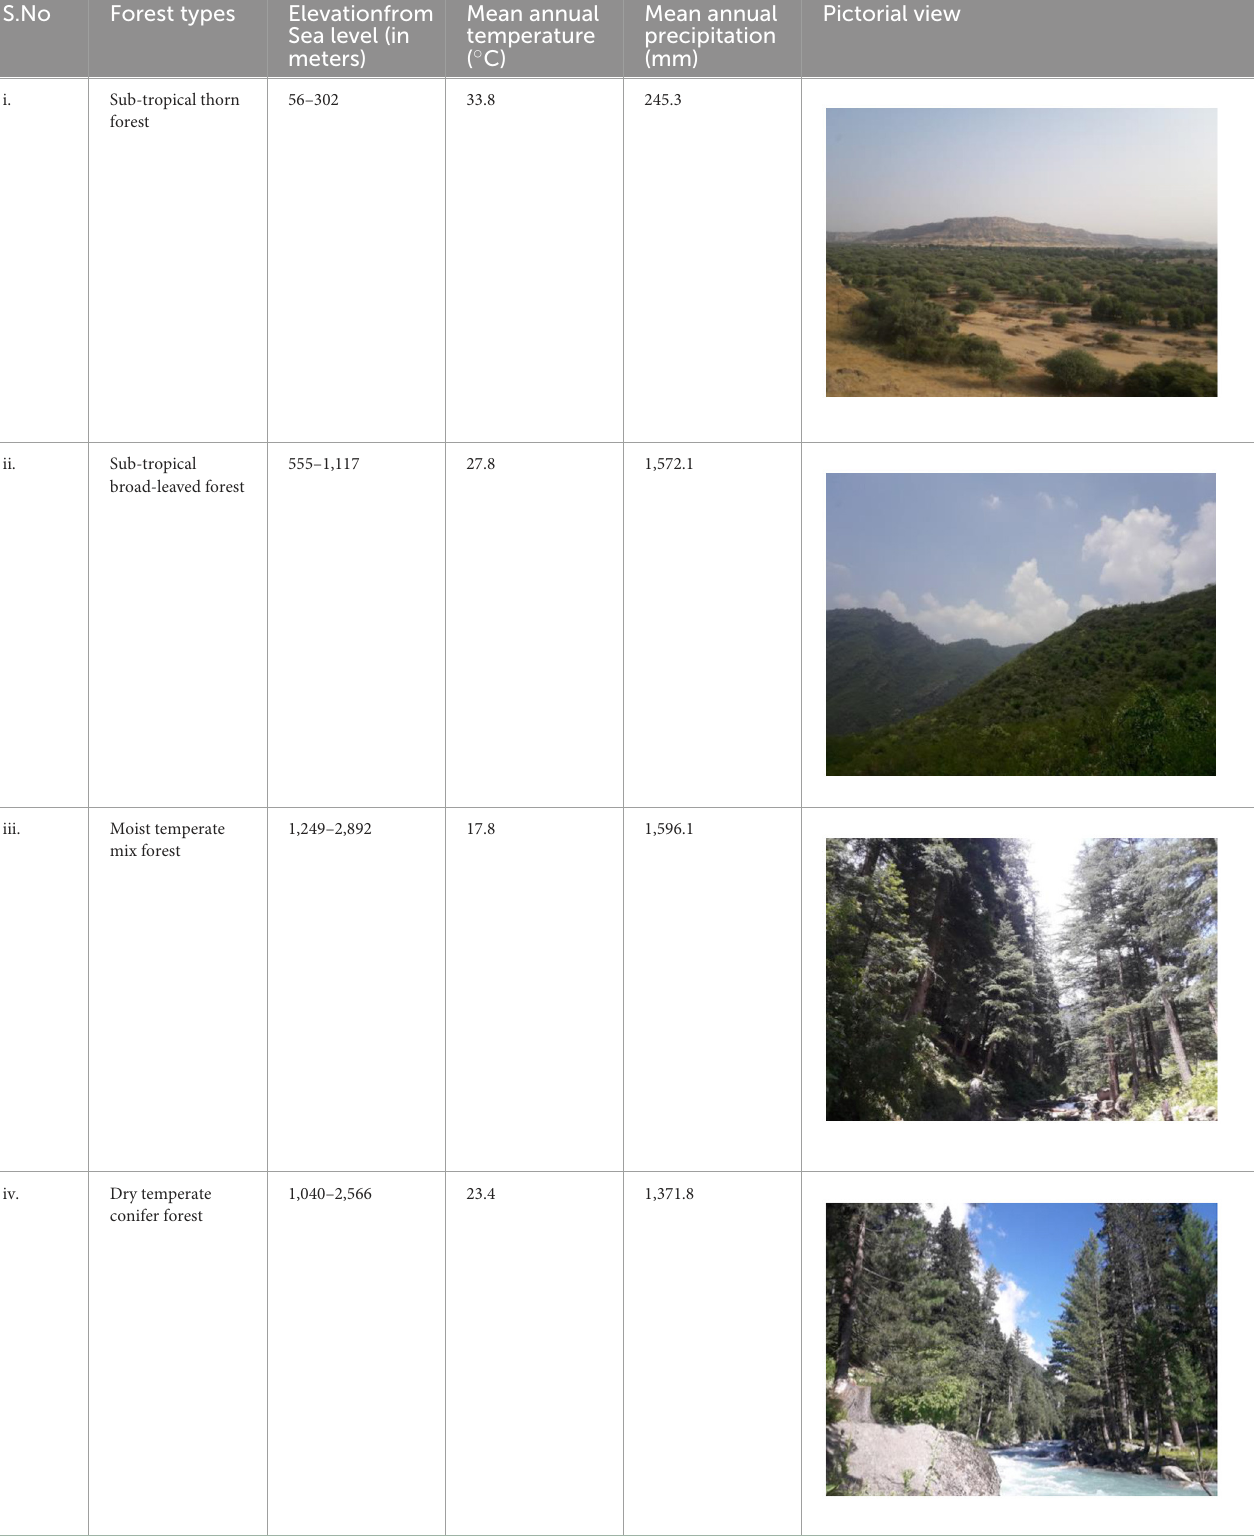
TABLE 1 Studied forest types along with their elevation range, mean annual temperature and precipitation.